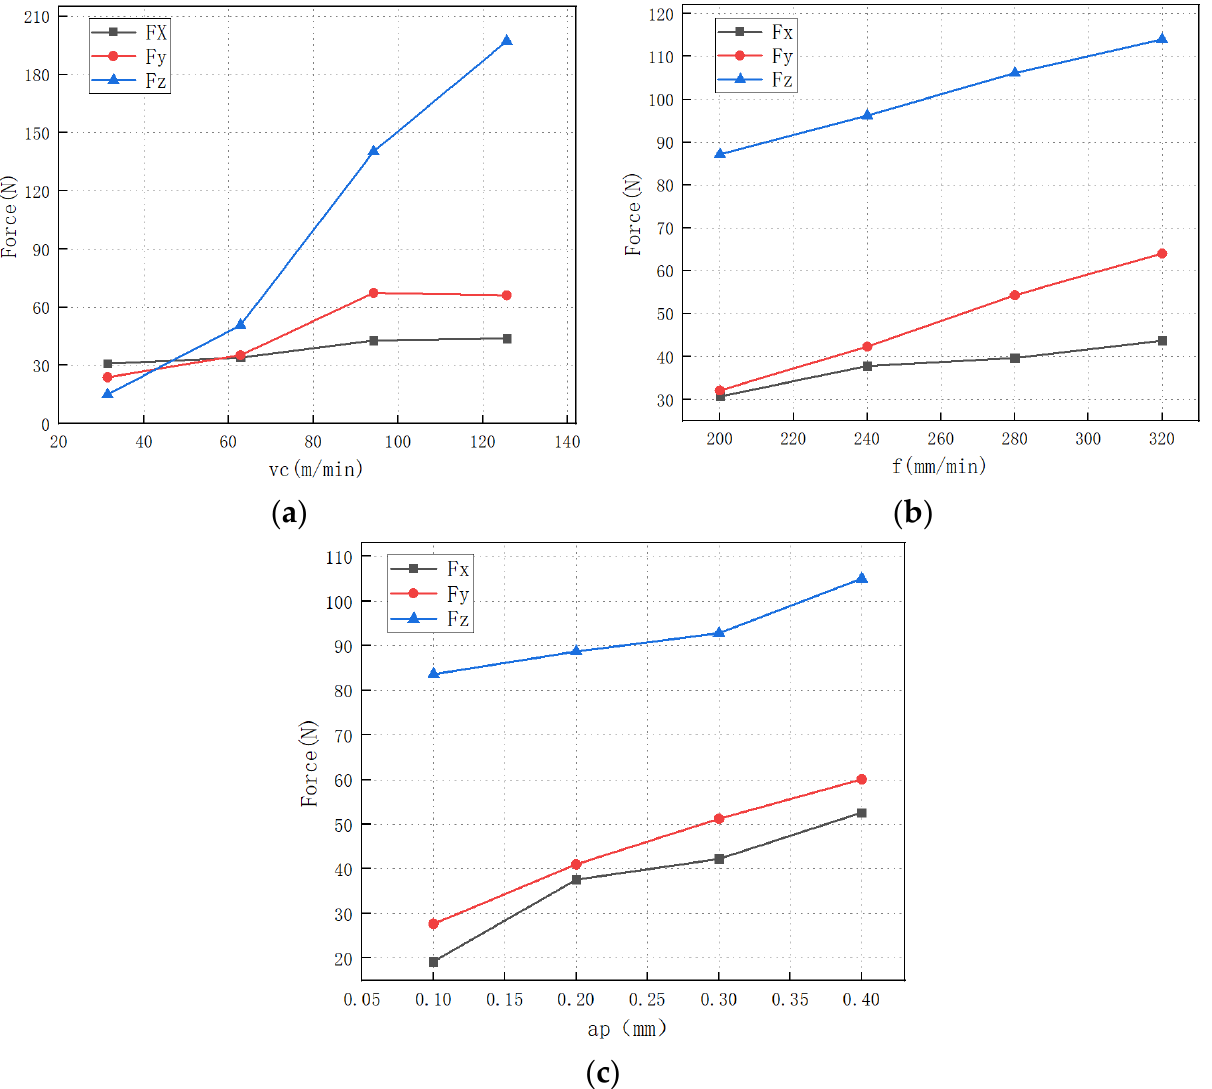
Figure 4. Variation of milling force with milling parameters. ( a ) milling speed; ( b ) feed rate; ( c ) milling depth.